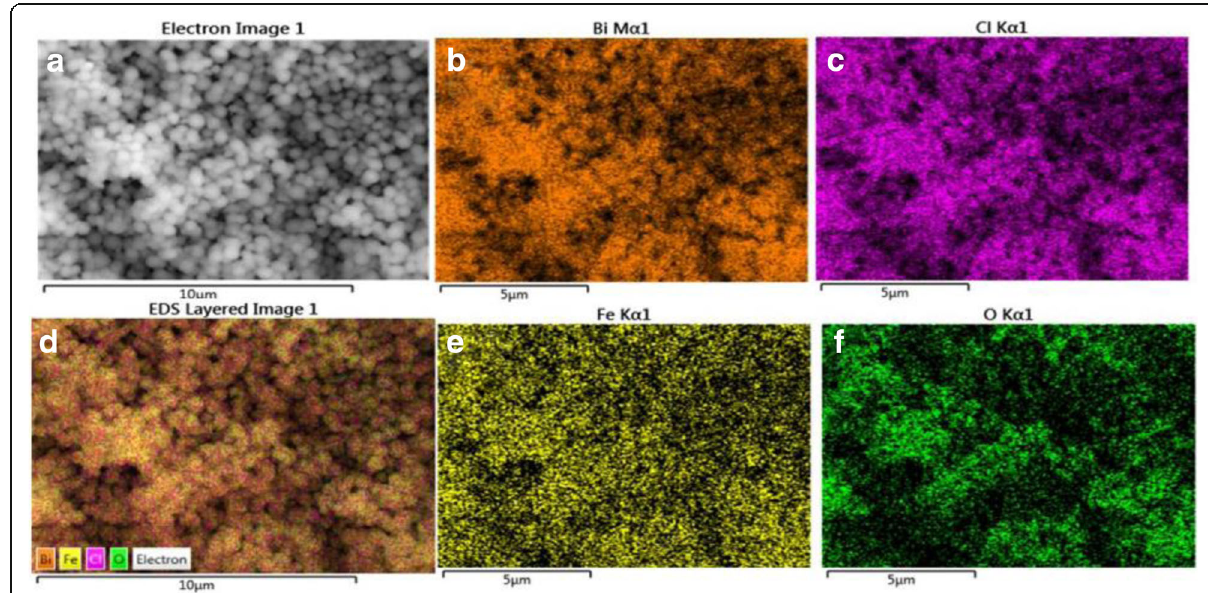
Fig. 4 Typical SEM images ( a ) and the elemental mapping of Bi ( b ), Cl ( c ), all elements ( d ), Fe ( e ), and O ( f ) of Fe/BiOCl